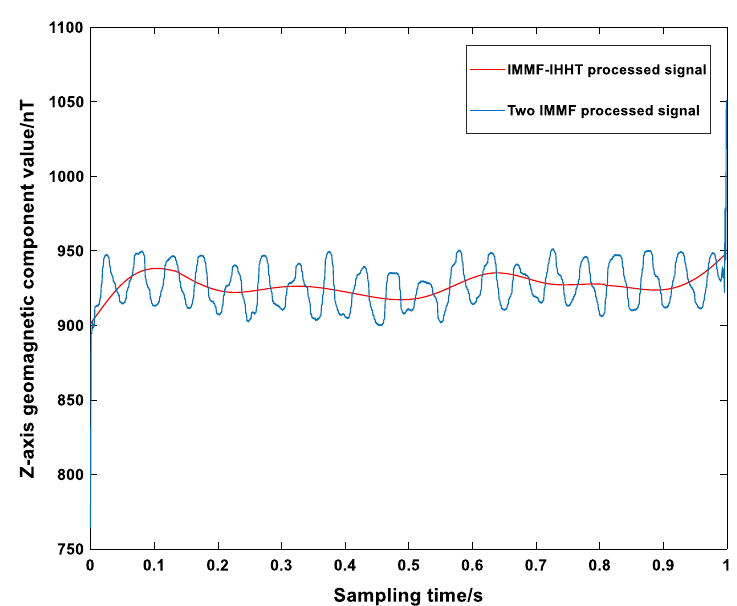
Fig. 18 Comparison between IMMF–IHHT processed signal and two IMMF processed